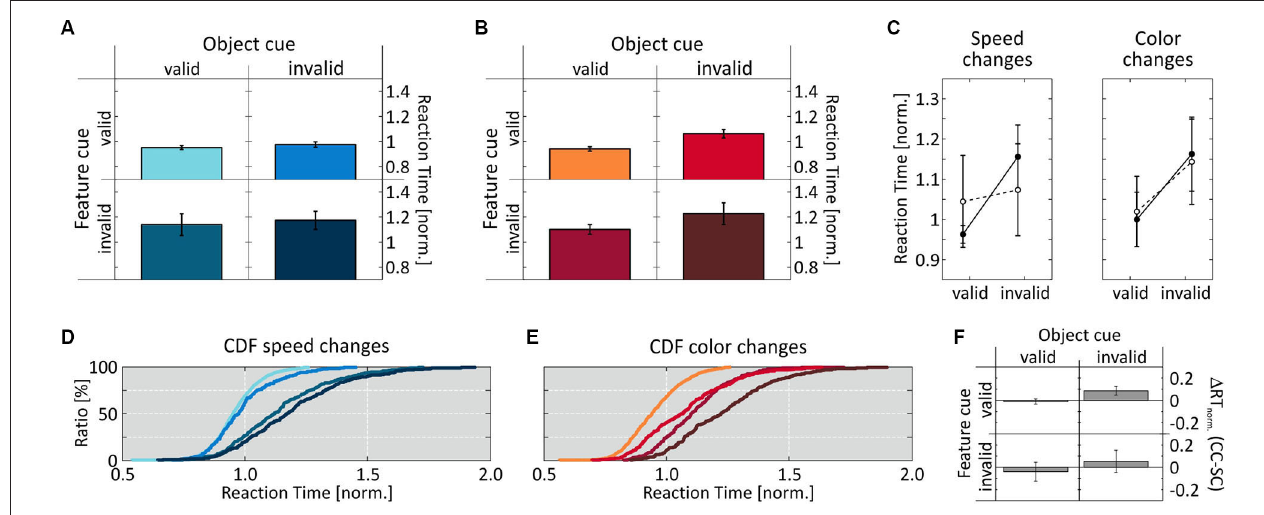
as a function of object-cue validity. (F) Speed- and color-change difference of mean normalized RTs for corresponding cue conditions. Conventions as in Figure 3